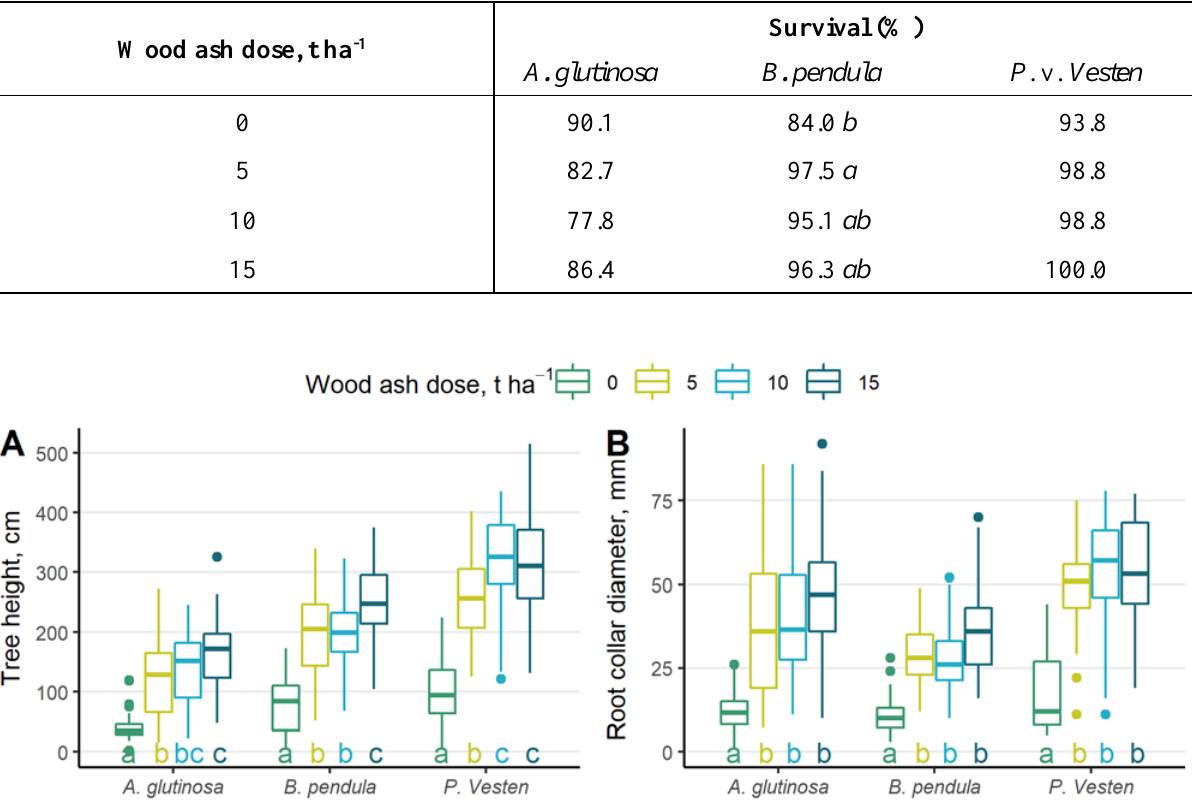
Figure 2. Studied tree species traits. (A) tree height; (B) root collar diameter. Letters denote significant (p adj . < 0.05) differences between fertiliser dose for each species. In box-plot graphs vertical lines show either the minimum or maximum value in 1.5*interquartile range (upper) or minus 1.5*interquartile range (lower), lower hinge - 25% quantile, upper hinge - 75% quantile, horizontal line in the middle represents the median. Dots show outlier